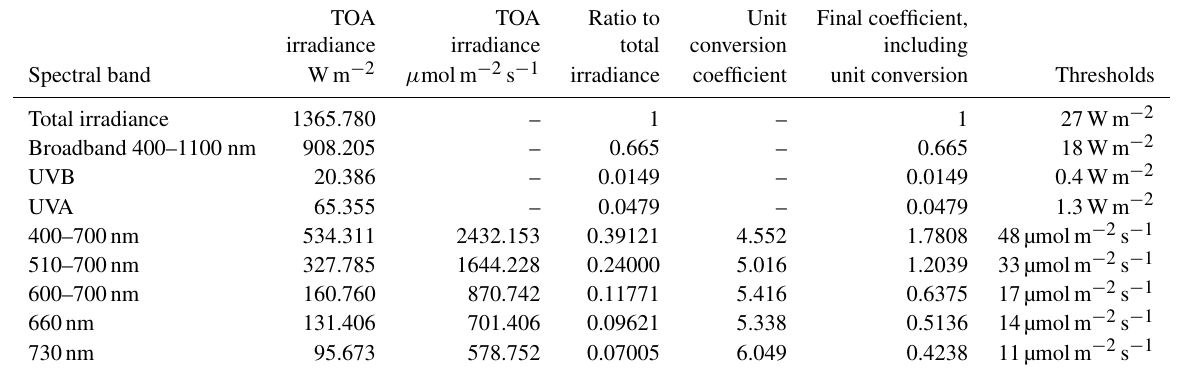
Table 4. Irradiance for each spectral band at the top of the atmosphere (TOA, in Wm − 2 ), its ratio to the total irradiance, conversion coefficients from Wm − 2 toµmolm − 2 s − 1 when needed, final coefficients for calculation of irradiance in spectral bands, and resulting upper